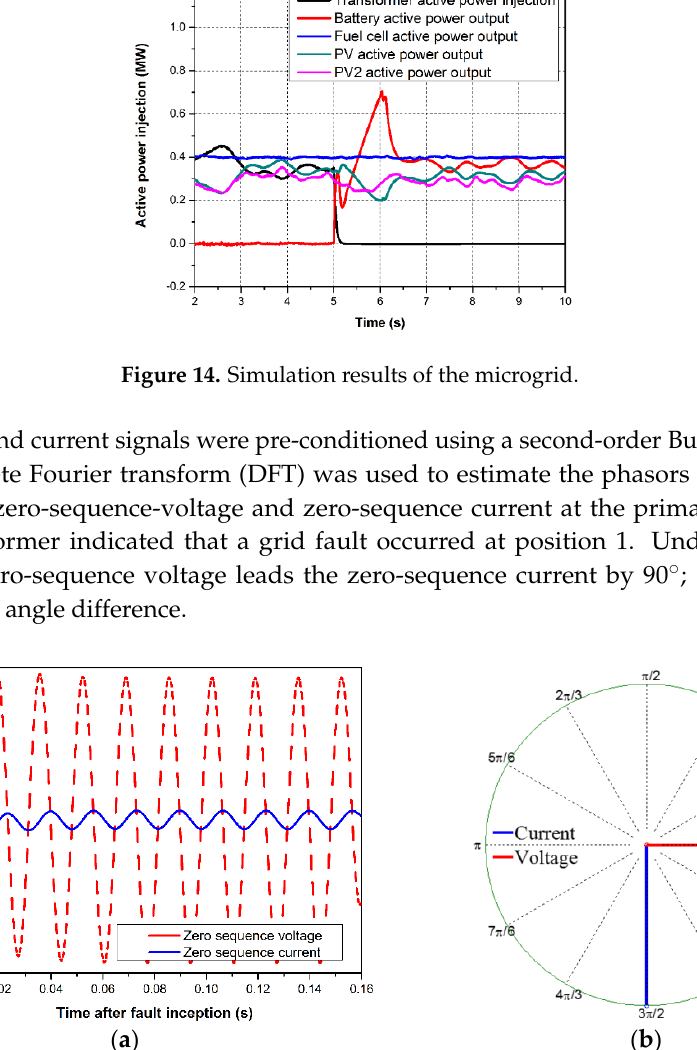
Figure 15. The zero-sequence voltage and current at the primary winding of the step-down transformer in the case of a grid fault in grid-connected mode: ( a ) Zero-sequence voltage and current; ( b ) Phase relation.